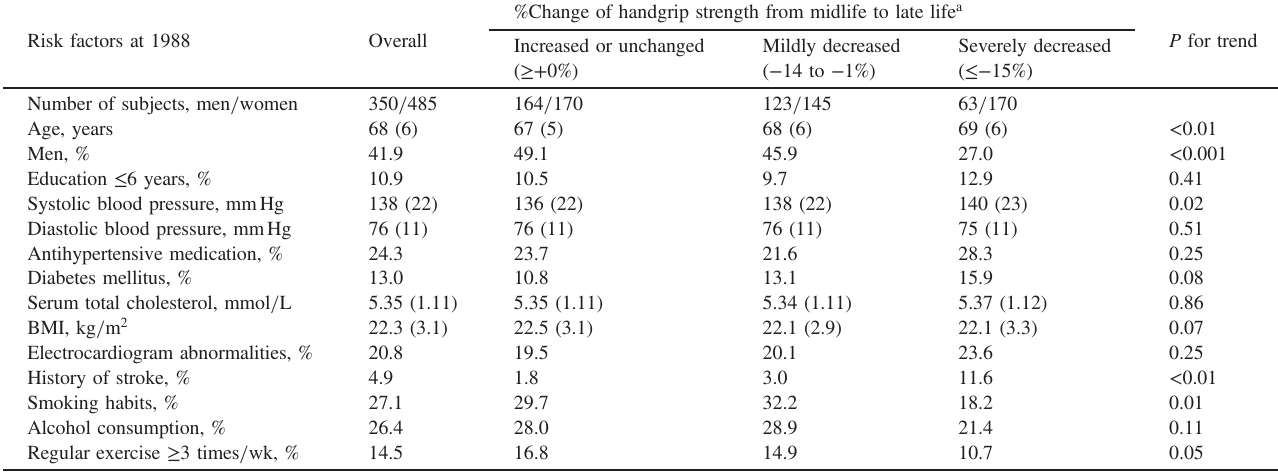
Table 4. Characteristics of participants at baseline (1988) according to the %change of handgrip strength from midlife (1973 – 1974) to late life (1988) Risk factors at 1988